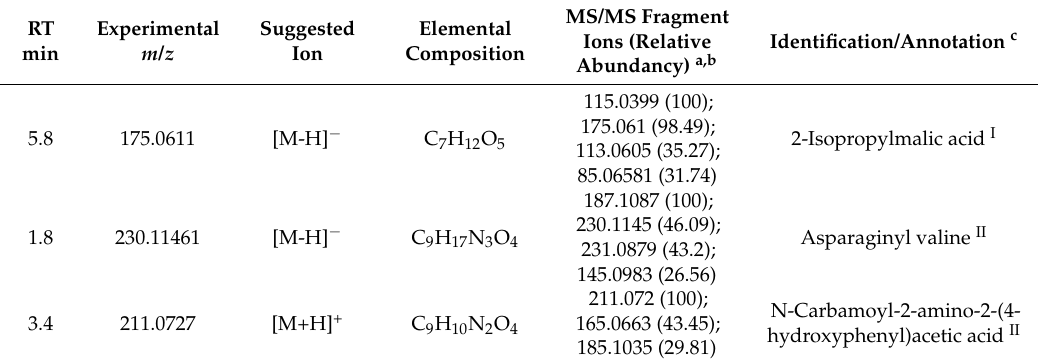
Table 3. Summary of mass spectral data supporting biomarker